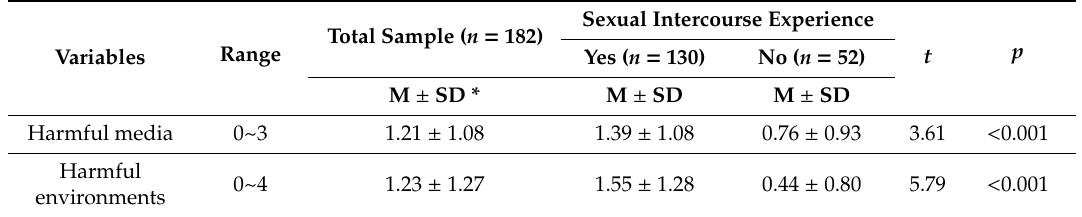
Table 3. Research variables based on sexual intercourse experience ( N =